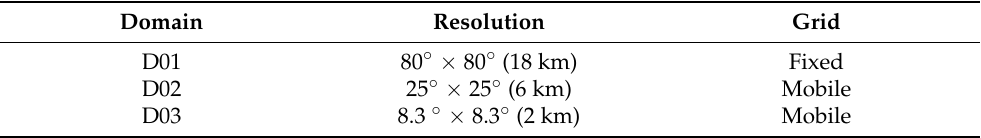
Table 1. Characteristics of the grids used for the HWRF model configuration. The fixed grid is centered in the initial position of the tropical cyclone, whereas the mobile grids are centered in the instant position of the tropical cyclone